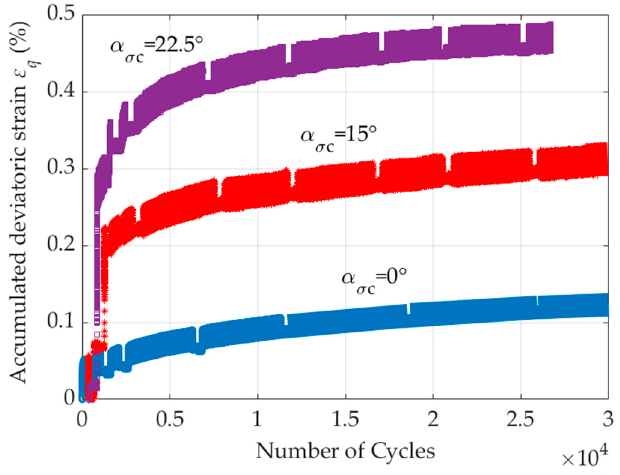
Figure 11. Evolution of deviatoric strain versus number of cycles for the three tests.